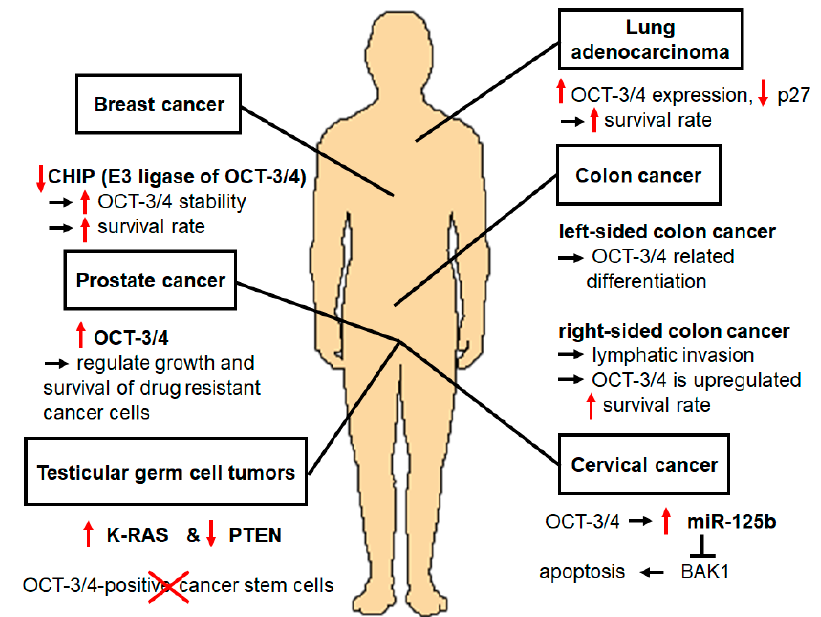
Figure 3. OCT-3/4 is also related to tumorigenesis of somatic cancers. Expression level of OCT-3/4 is related to development of cancers such as cervical cancer, colon cancer, and breast cancer, as well as testicular germ cell tumors, drug-resistant cells, and undifferentiated tumor-initiating cells; accordingly, OCT-3/4 can be a novel therapeutic target for the treatment of cancers.